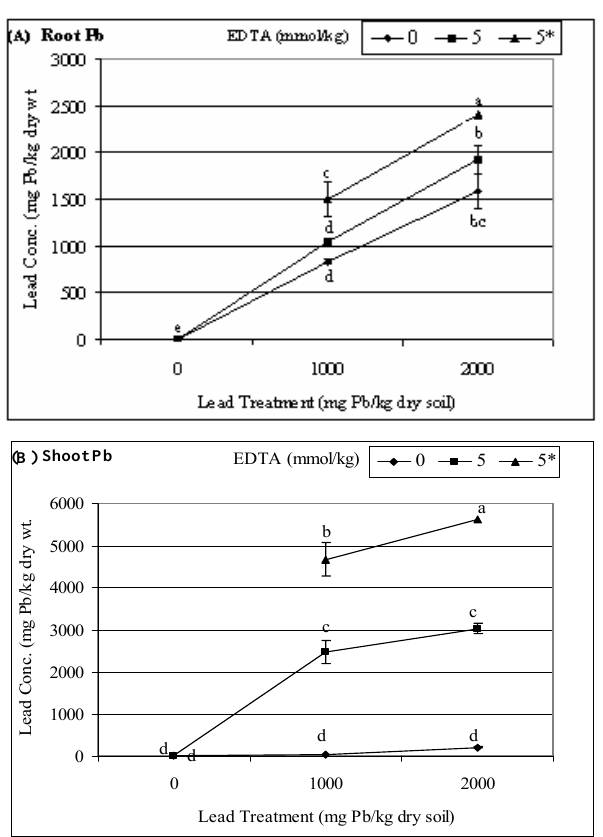
Figure 1: Root (A) and shoot (B) Pb concentrations of tall fescue grown at various levels of Pb and chelates. Means with a common letter do not differ significantly using Fisher's Protected LSD test (P=0.05). An error bar indicates the standard error of the mean of 4 replications. (* indicates that an aqueous solution of acetic acid was added at the same time as the aqueous solution of